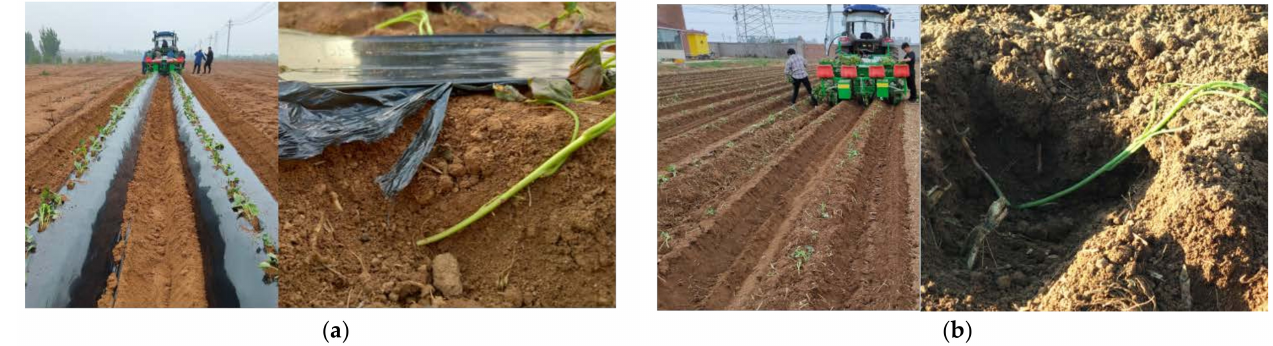
Figure 12. 2CGFS-2 compound sweet potato transplanter working in RBF and RB cultivation systems. ( a ) The designed transplanter working in RBF cultivation system and ( b ) RB cultivation